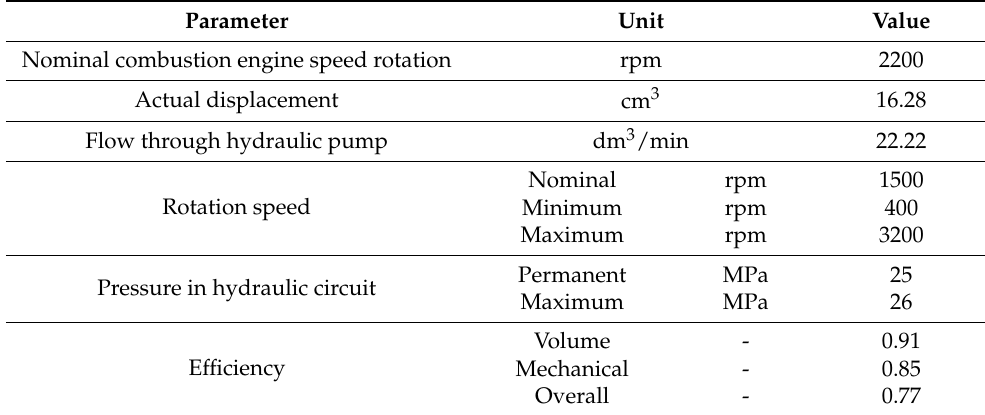
Table 5. Input parameters.